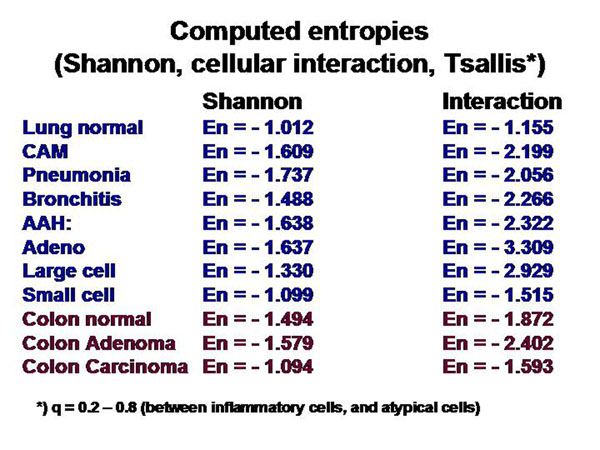
Computed entropies of the model. No direct association of amount of entropy and clinical behavior of the disease was obtained